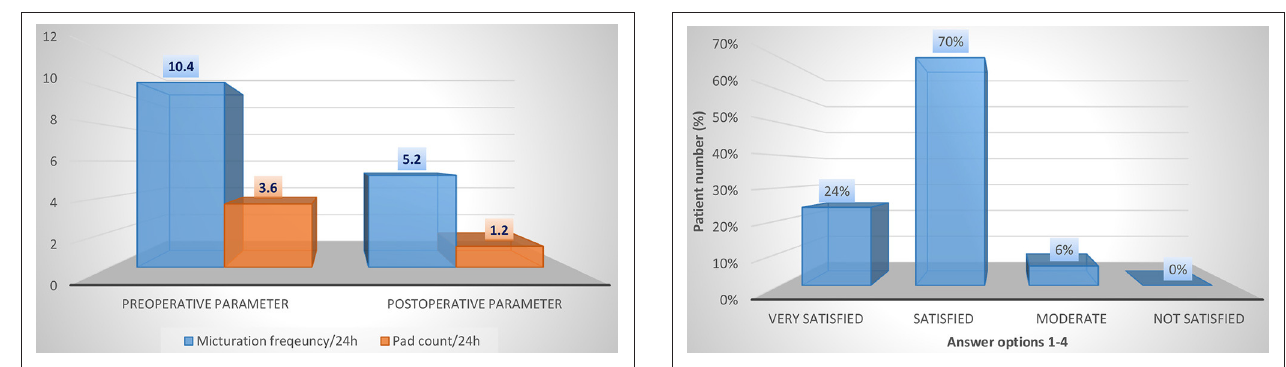
FIGURE 3 | CSQ-8 question 5: How satisfied were you with the course of treatment?.